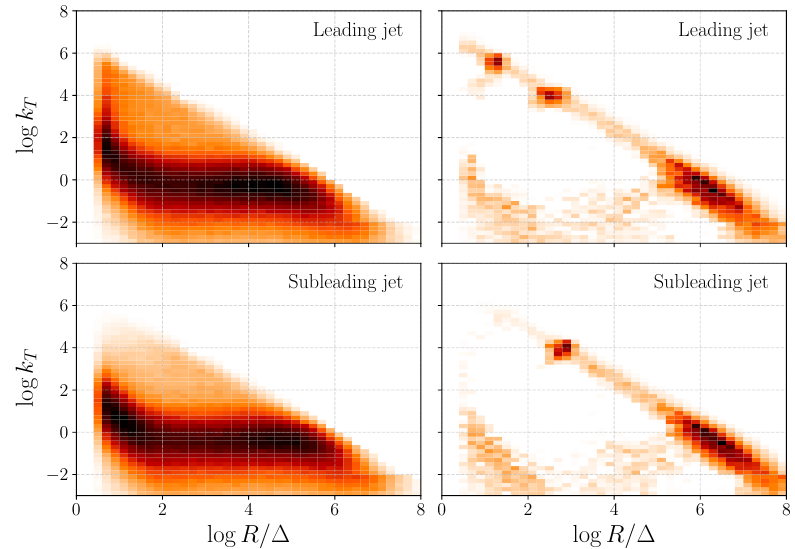
Figure 14 . The LDA extracted theme 1 (left) and theme 2 (right) distributions for the leading (upper plots) and subleading (lower plots) jets obtained on a mixed W 0 / QCD sample with S/B at 5%, where only the log k T and log R= (cid:1) observables were used. Shown are results for the model with priors (cid:26) = 0 : 1 and (cid:6) = 1 which yields the biggest inverse perplexity. See text for